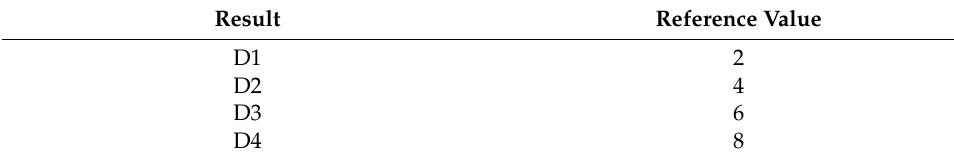
Table 9. Reference value of the result.